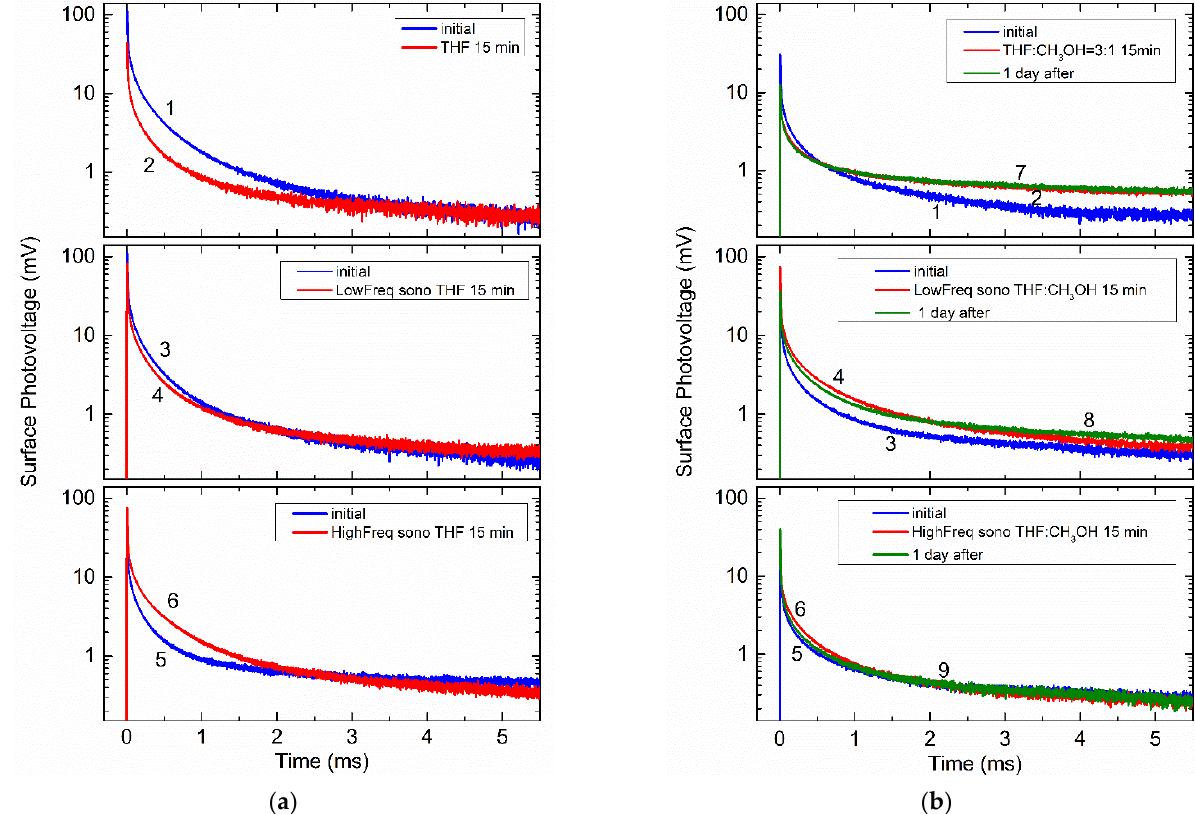
Figure 6. Time-dependent SPV of Si samples before (curves 1, 3, and 5) and after chemical (curves 2) and sonochemical treatments at about 28 kHz (curves 4) and 400 kHz (curves 6): ( a ) in tetrahydrofuran; ( b ) in tetrahydrofuran/methan ol mixture with a volume ratio of 3/1. Green curves 7–9 exemplify the SPV evolution one day after appropriate chemical and sonochemical treatments were